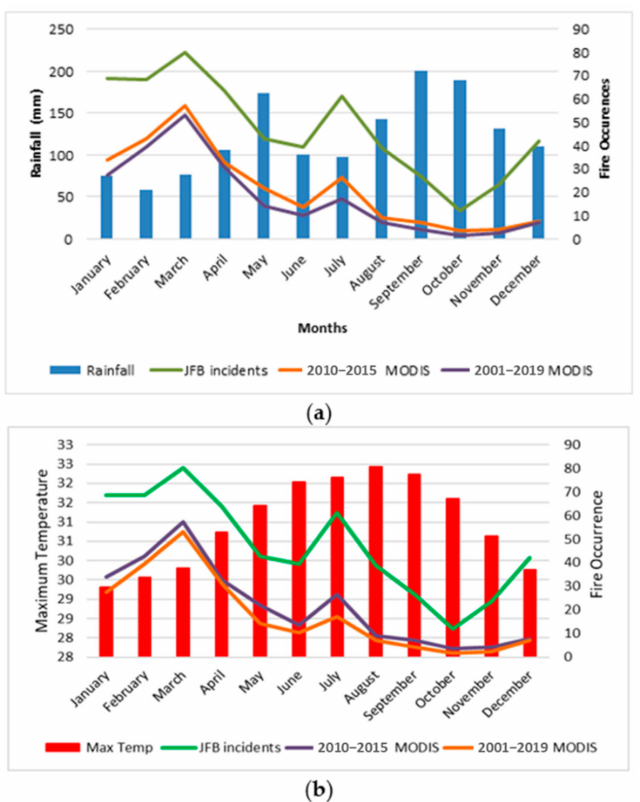
Figure 3. Climatologies of monthly fire frequency for Jamaica from JFB and MODIS and ( a ) rainfall and ( b ) maximum temperature for 2010–2015. Climatology of MODIS fire frequency for 2001–2019 is also